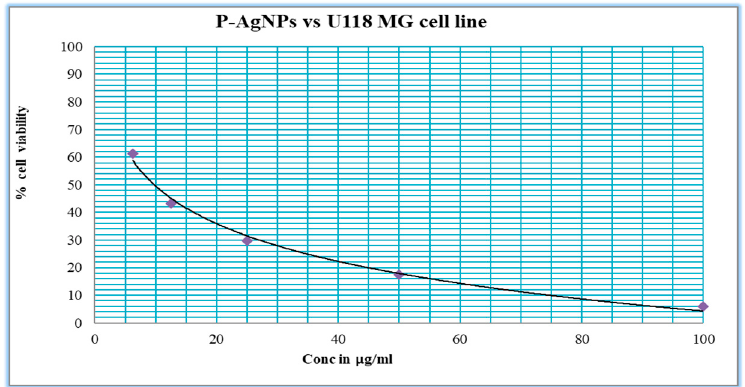
Figure 12. Graphical representation of percentage cell viability of P. alba AgNPs on U118 MG cancer cell line.